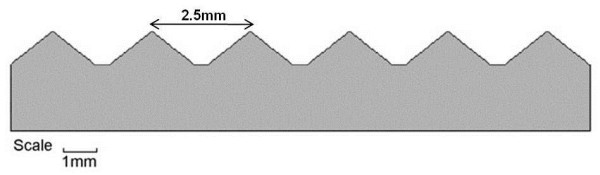
Cross-sectional frontal view of textured insole.